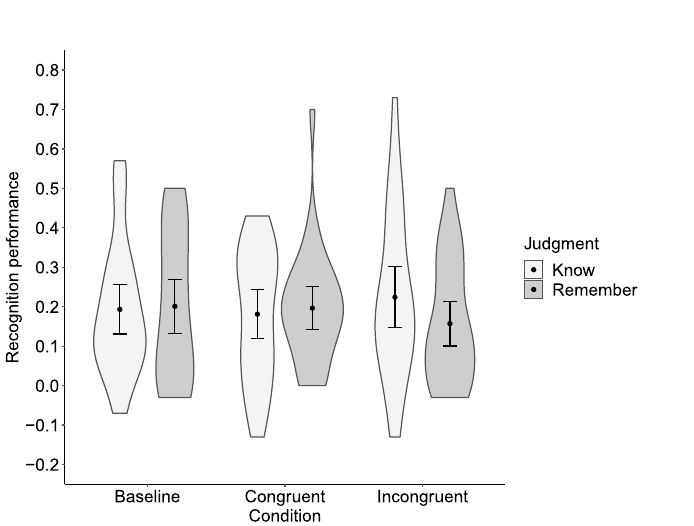
Figure 3. Recognition performance in Experiment 1. The Remember-recognition performance was calculated by subtracting the proportion of Remember judgments for new items from that for old items learned in each condition. The Know-recognition performance was calculated in the same manner. Black dots depict means. Error bars depict 95% confidence intervals. Violin plots show the data